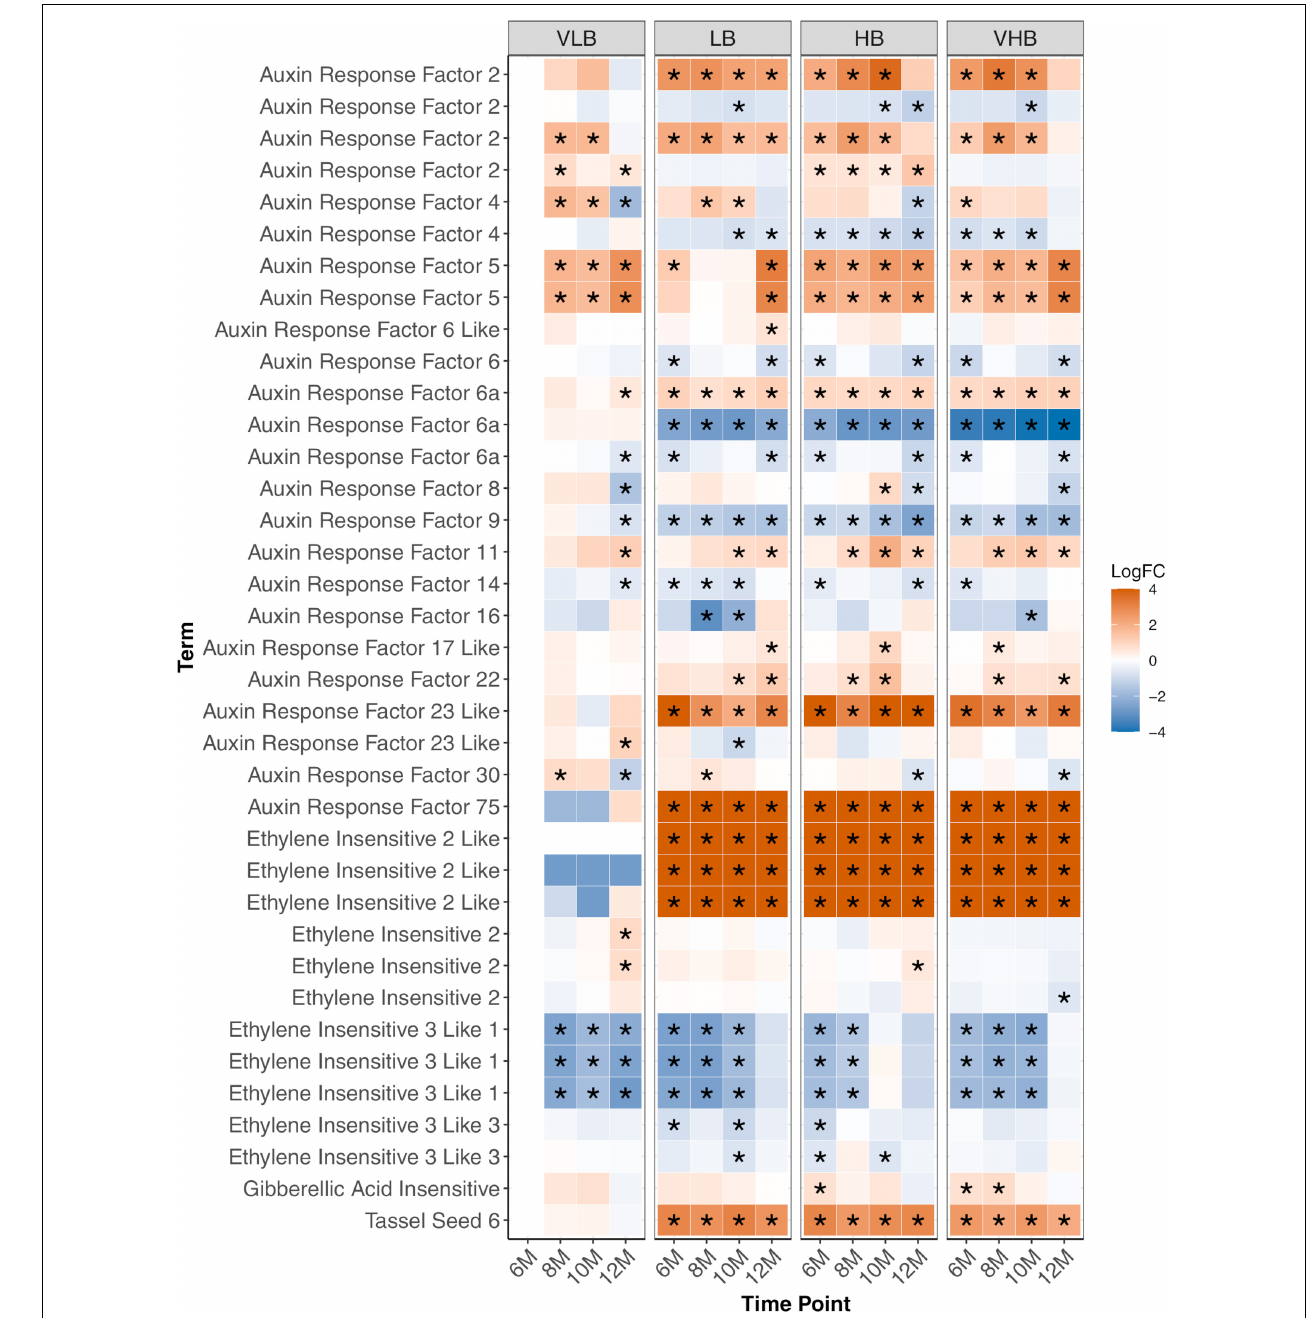
FIGURE 4 | Expression profiles of genes related to hormone metabolism. Asterisks indicate genes with differential expression for a particular combination of genotype and time point. The age of plants in the x axis is shown in months. VLB: very low ◦ Brix, LB: low ◦ Brix, HB: high ◦ Brix and VHB: very high ◦ Brix. All tests considered 6-month-old VLB as a reference